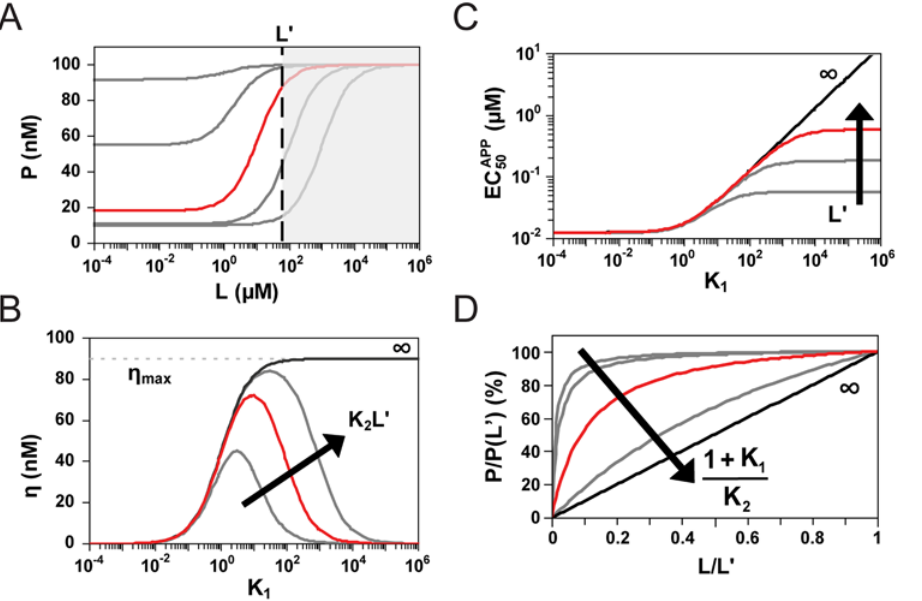
Figure 5. Placing an upper limit on the ligand concentration range alters the observed tuning properties. (A) Placing an upper limit on the ligand concentration (L’) restricts access to the full response curve. This limit affects the dependence of (B) the dynamic range ( g ) and (C) the apparent EC 50 (EC 50APP ) on the conformational partitioning constant (K 1 ) and the aptamer association constant (K 2 ) as demonstrated for a thermodynamically-driven riboswitch. The maximum dynamic range ( g max ) is proportional to the difference between regulatory activities for conformations A (K A ) and B (K B ) normalized to the respective degradation rate constants k dMA and k dMB . (D) Normalized response curves for fixed L’ and increasing values of (1 + K 1 )/K 2 , which equals EC 50 under ligand-saturating conditions. Parameter values are identical to those reported in Figure 2 with L’=60 m M.